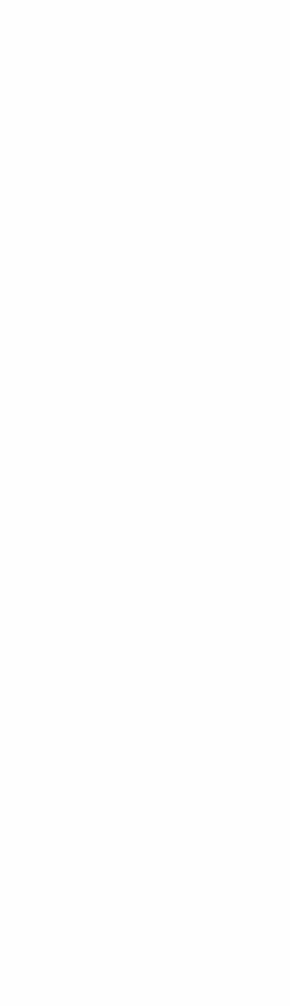
Fig. 1: Three fundamental applications of ERFs: (a] shearing in clutches, (b) flow in hydraulics, and (c) squeezing in oscillation